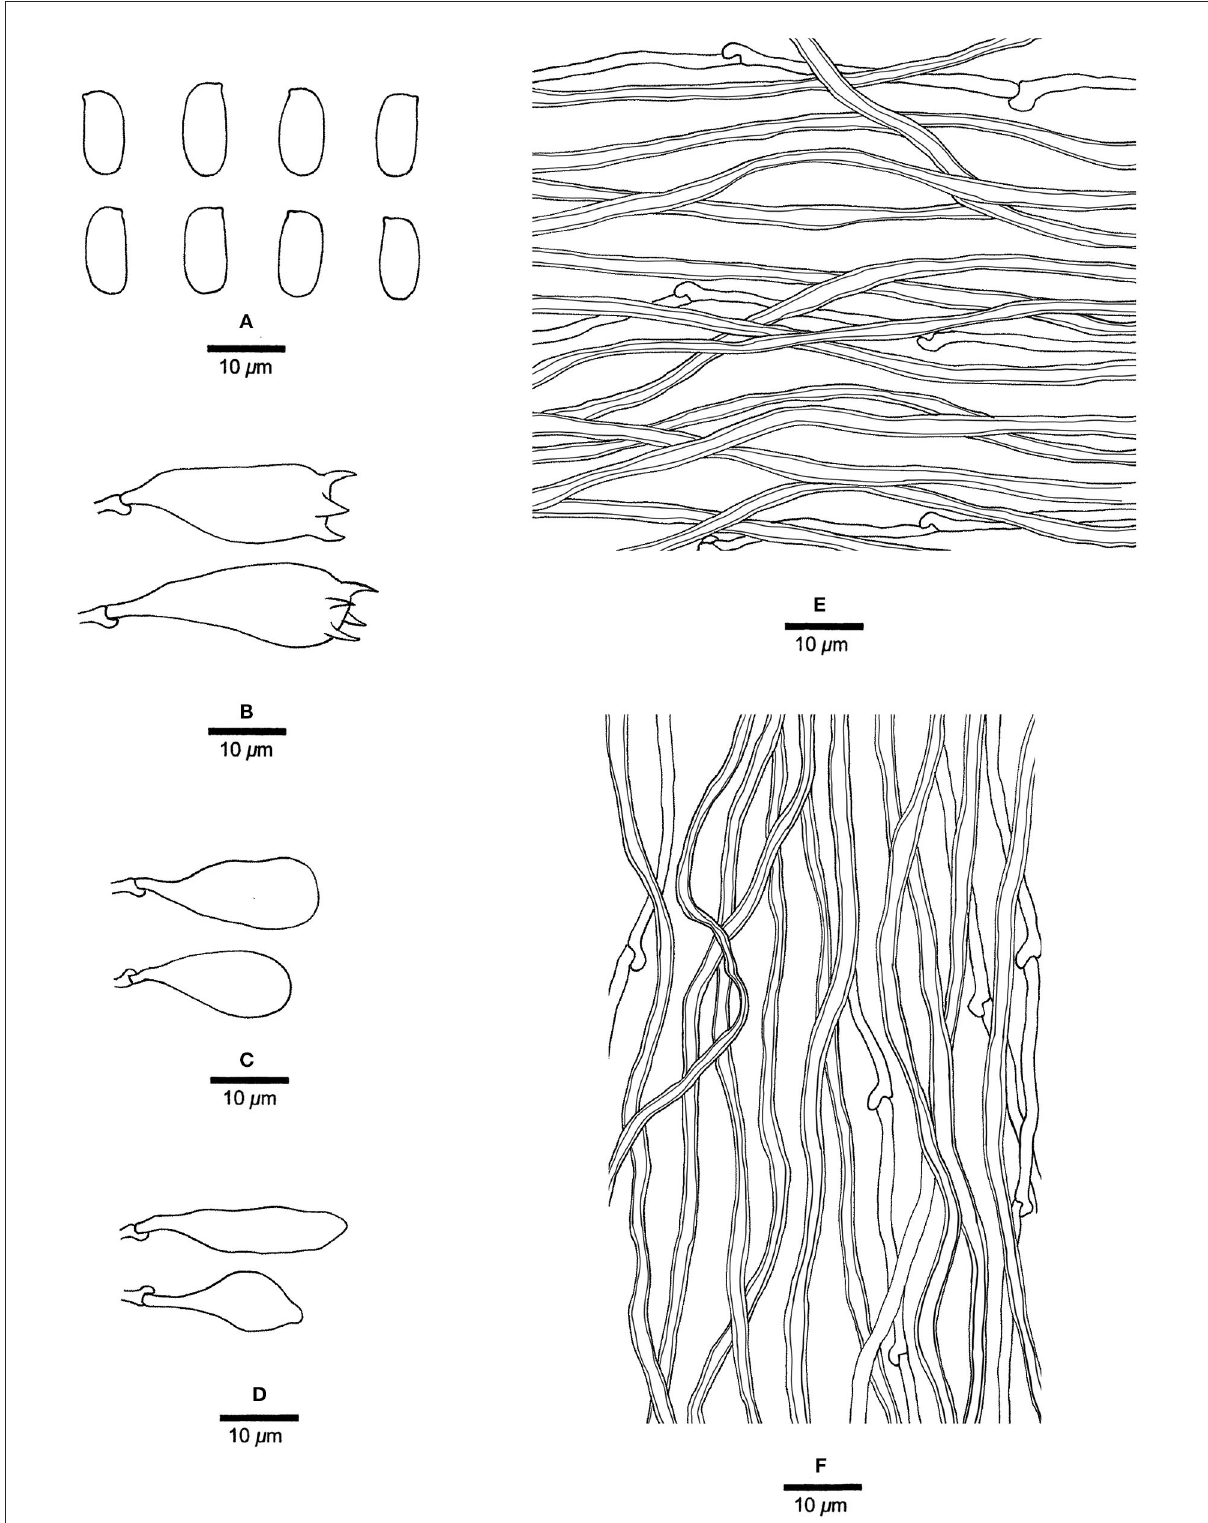
FIGURE10 Microscopic structures of Mariorajchenbergia subleucoplaca (drawn from Ryvarden 11049). (A) Basidiospores. (B) Basidia. (C) Basidioles. (D) Cystidioles. (E) Hyphae from subiculum. (F) Hyphae from tube